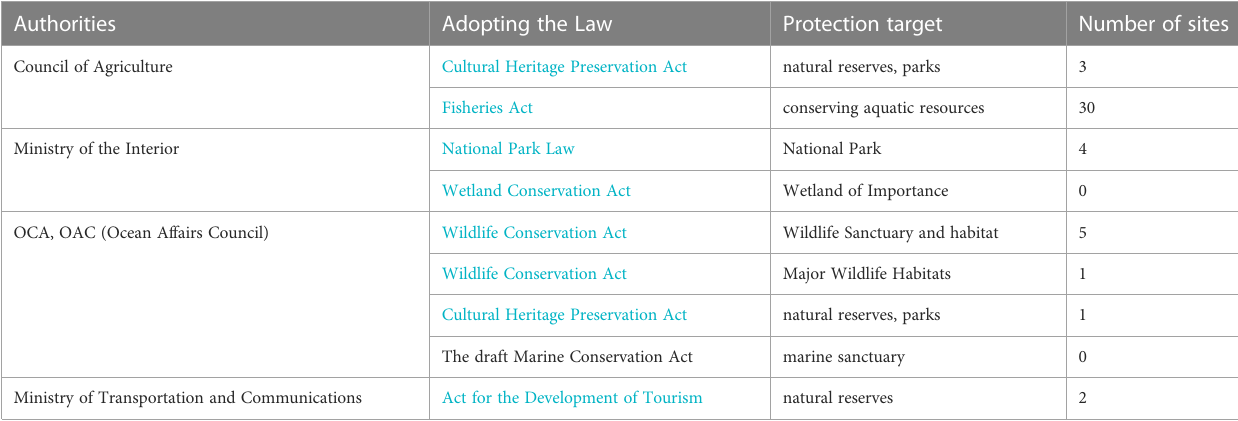
TABLE 4 The authorities announced by the law of marine protected